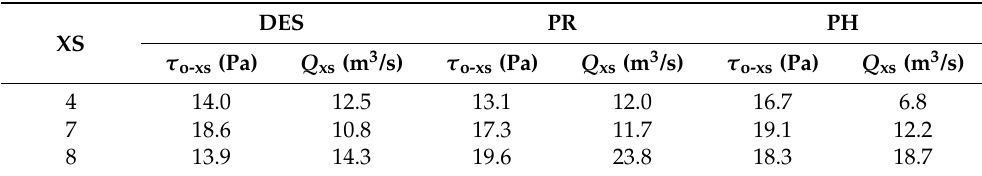
Table 6. Estimated proxy discharge for bankfull conditions ( Q xs ) and BSTEM process-based predic- tions of τ o ( τ o-xs ) at cross-sections XS #4, XS #7, and XS #8 for the Design (DES), Post-Restoration (PR), and Post-Hurricane (PH) geometries.